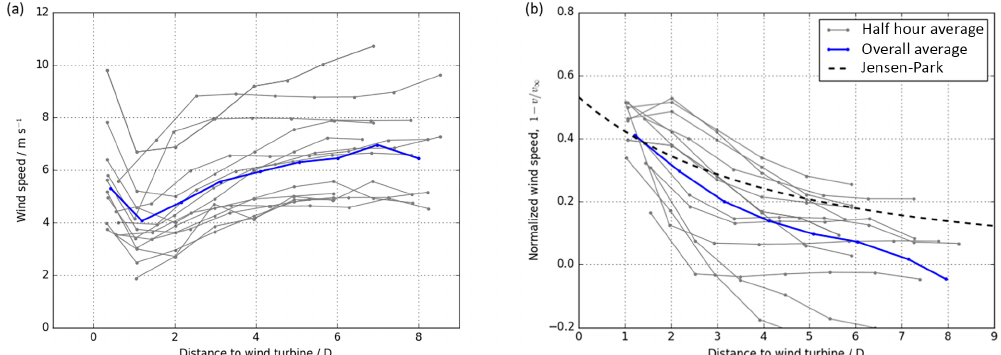
Figure 8. Multi-Doppler wind speed measurements plotted against distance to the turbine (a) , and wind speed deficit normalized to undis- turbed wind speed measurement on tower 20/tse04 at 80m (b) on 17 May 2017.